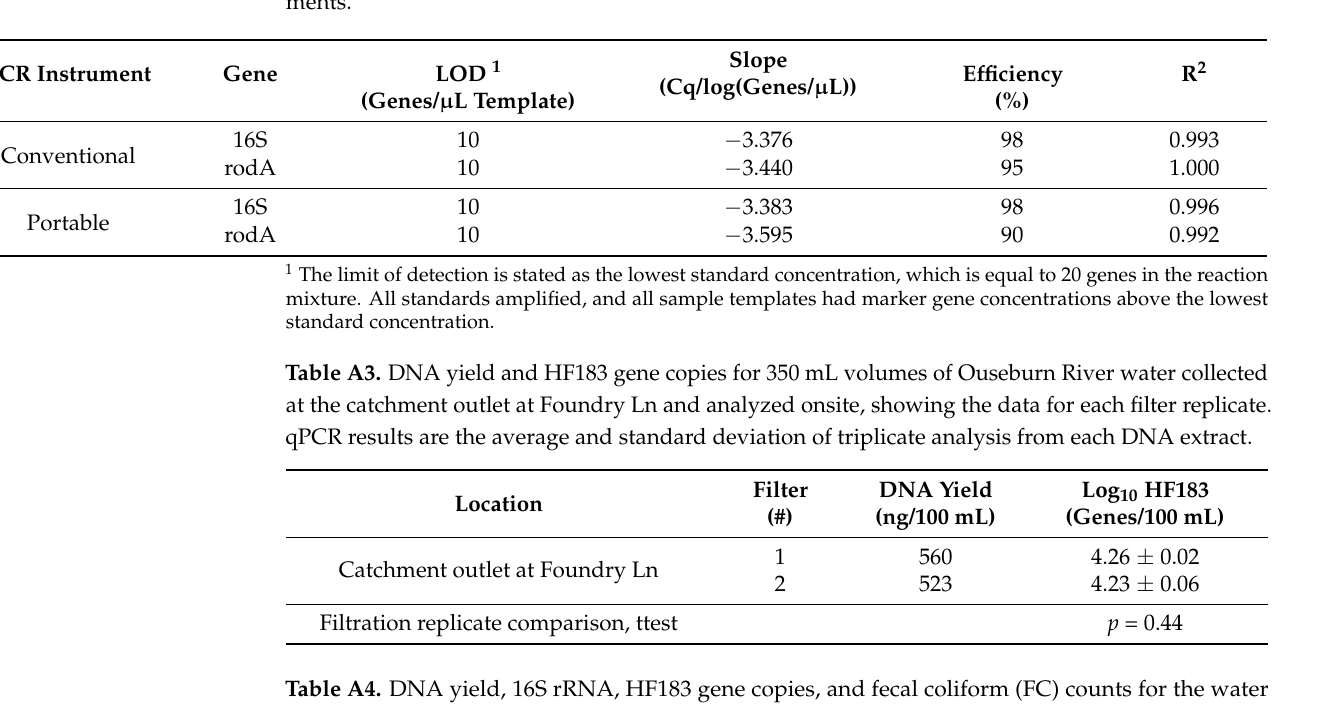
Table A2. Comparison of calibration curve metrics for the conventional and portable qPCR instru- ments.